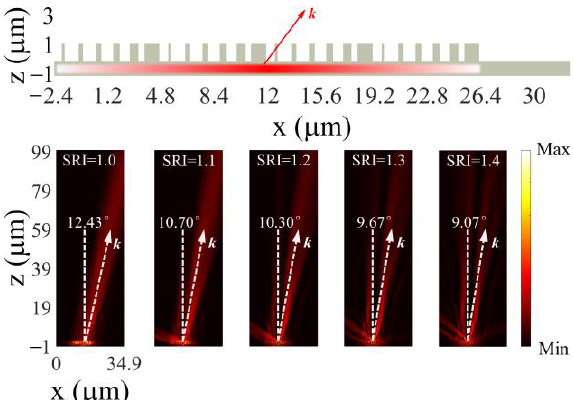
Figure 6. Deflection behaviors of a continuously tunable monolithic deflector. Top : configuration of the deflector. Bottom : simulated intensity profiles of the deflected beams under varied SRI.